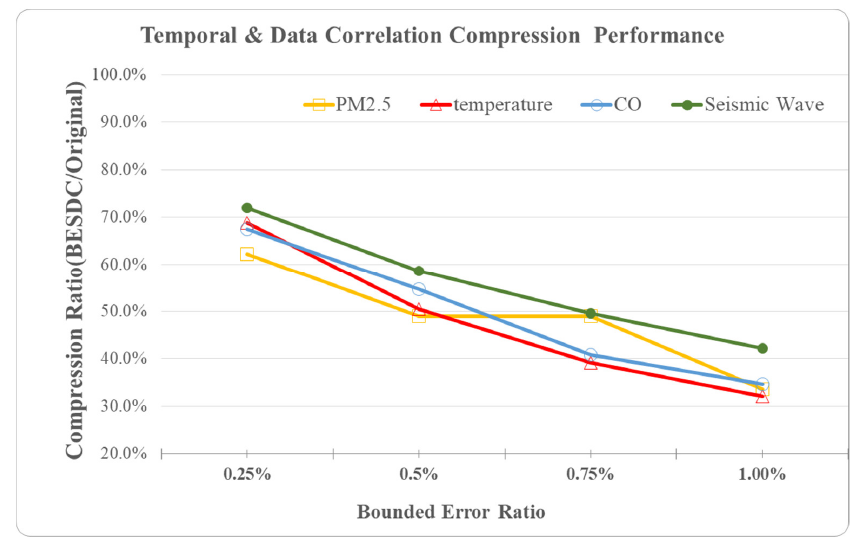
Figure 6. Data compression ratio in ED via BESDC.